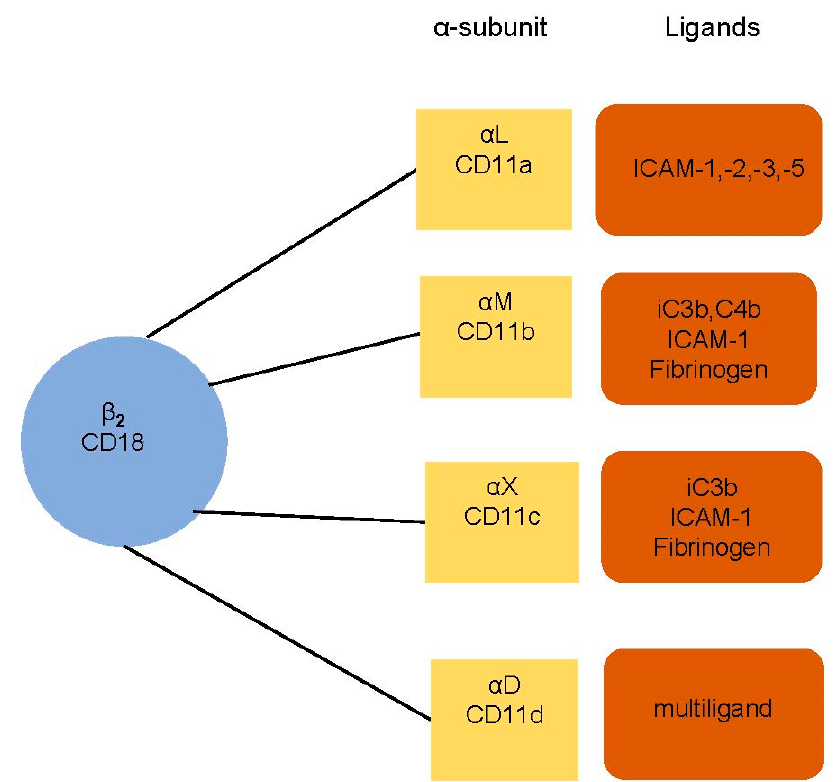
Figure 1. Leukocyte integrins and their ligands. The subunit CD18 ( β 2 integrins) is associated with α subunit ( α L CD11a, α M CD11b, α X CD11c, and α D CD11d). The integrins bind to a specific ligand—intercellular adhesion molecules (ICAMs), fibrinogen, or complement components (iC3b, C4b, c3b). CD11d is a multiligand receptor.